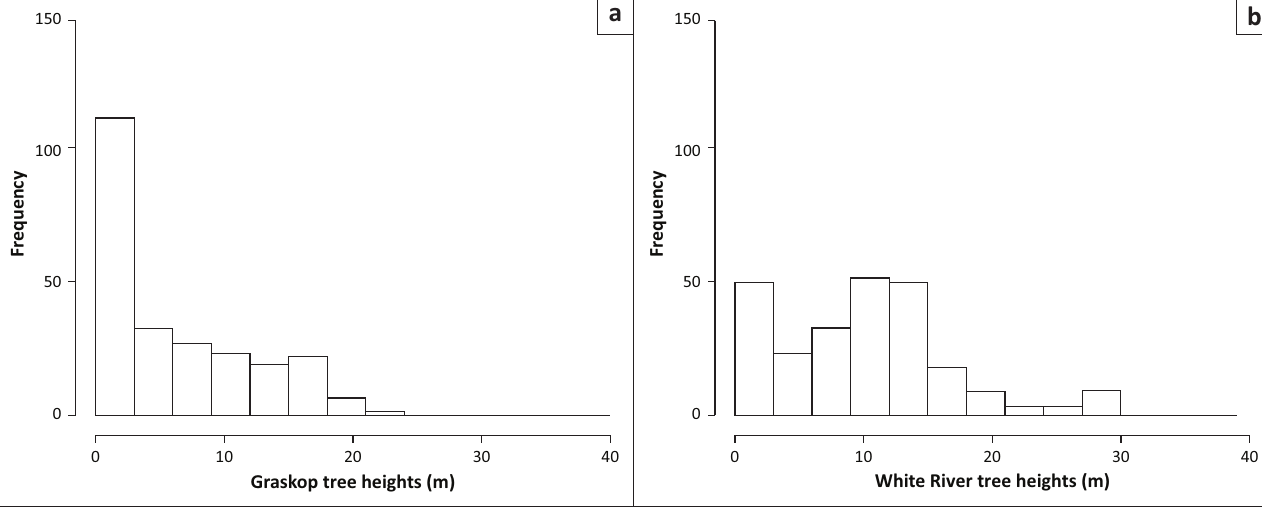
FIGURE 6: Height size class distributions of all the populations in (a) Graskop and (b) White